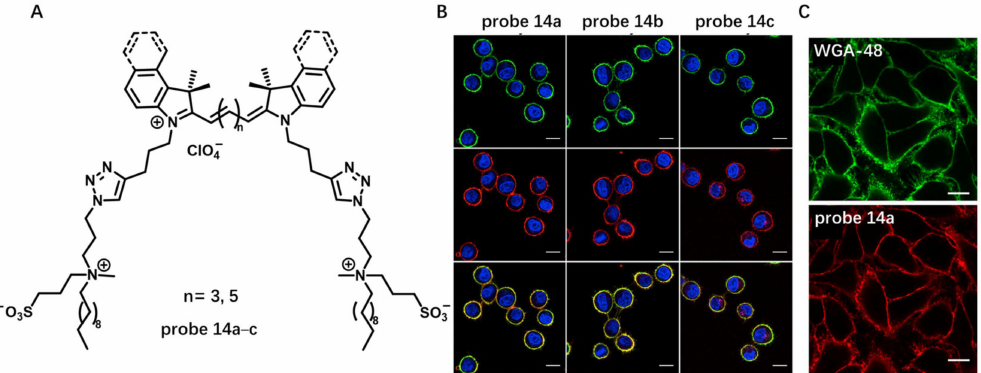
Figure 14. ( A ) Chemical structure of probes 14a – c . ( B ) Confocal images of live cells with probe 14a – c . Scale bar: 15 µ m. ( C ) A more homogeneous staining of CM using probe 14a than using WGA-48. Scale bar: 15 µ m. Copyright 2019 Elsevier [71].